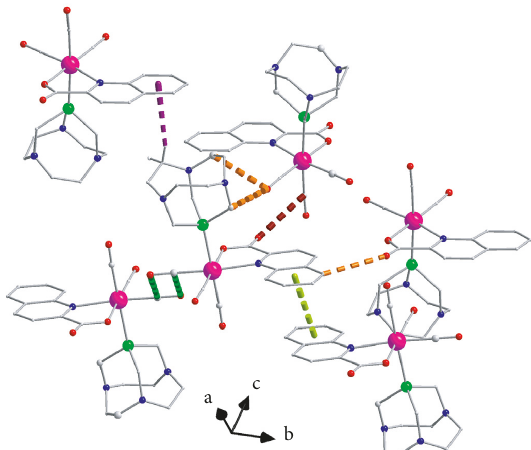
Figure 3: Intermolecular interactions observed in the structure of compound 1b . Dashed thick dark green (antiparallel C dark red lines indicate carbonyl-carbonyl interactions (C-O 5 · · · C 1 -O 1 ). Dark violet dashed lines indicate C 19 -H 19 · ·· π interactions. Light green dashed lines indicate π · ·· π between quinaldic ligands and orange dashed lines indicate C 18 -H 18 A · · · O 2 , C 14 -H 14 B ·· · O 2 and C 9 - H 9 · ·· O 5 hydrogen bonds.